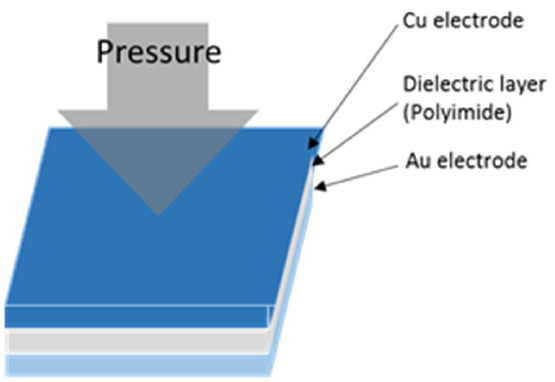
Figure 4. Schematic diagram of micro pressure sensor.